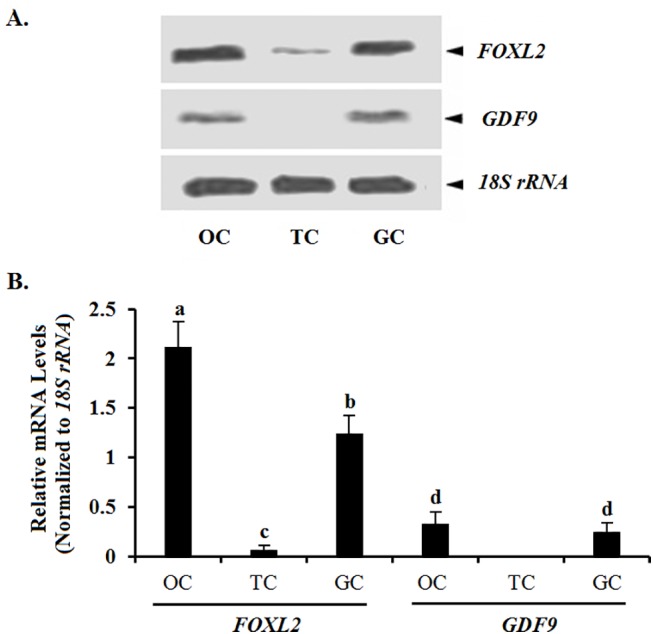
Northern blot analysis of the expression of FOXL2 and GDF9 mRNA in oocytes (OC), theca cells (TCs), and granulosa cells (GCs) from prehierarchical follicles (6–8 mm in diameter).Relative expression was analyzed by Northern blot using FOXL2 and GDF9 cRNA probes; an 18S rRNA cRNA probe (208 bp) was used as a loading control. The results were examined on a 1% agarose gel containing 1 M formaldehyde as assessed by electrophoresis. Hybridization signal intensity was quantified densitometrically after phosphorimaging (shown in A), and normalized for loading by comparison to the hybridization signal for 18S rRNA. The signal intensity of FOXL2 or GDF9 genes was expressed as the ratio18S rRNA signal in arbitrary units shown in B (n = 5 per mean ± SEM). Statistical significance was set at P < 0.01, and marked with different superscript letters a, b, c, and d.